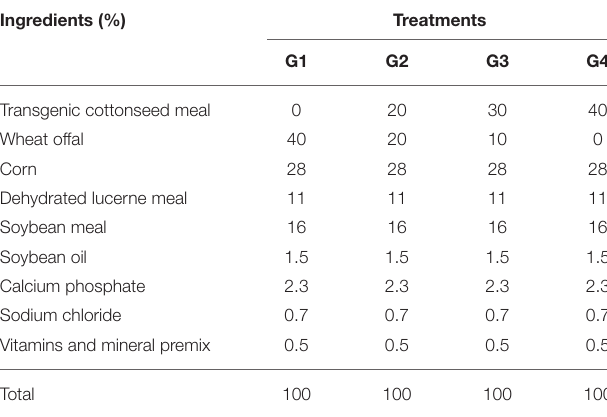
TABLE 1 | Compositions of experimental